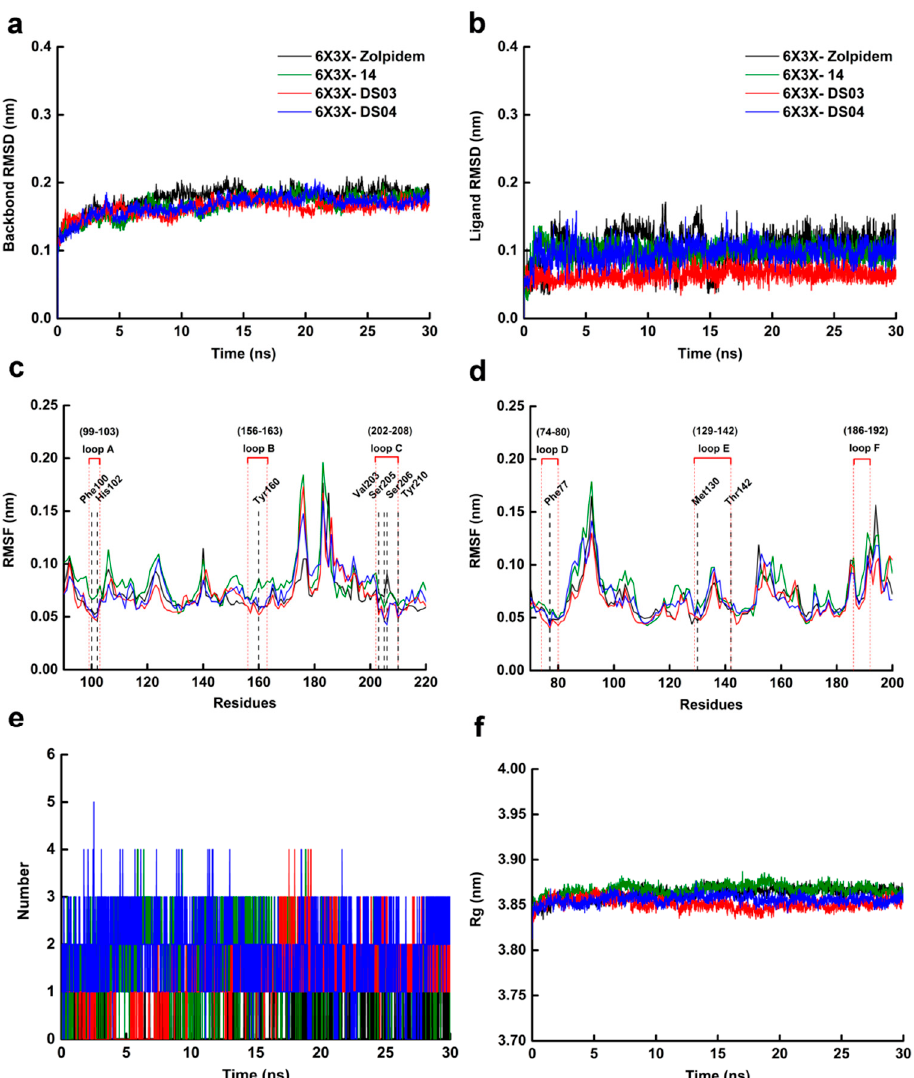
Figure 13. The results of the 30 ns MD simulations of four protein–ligand complexes 6X3X-zolpidem (black), 6X3X- 14 (green), 6X3X- DS03 (red) and 6X3X- DS04 (blue). ( a ) The RMSDs of the 6X3X backbone atoms. ( b ) The RMSDs of compounds (zolpidem, compounds 14, DS03 and DS04 ). ( c ) The residue RMSFs of loop A–loop C in the 6X3X. ( d ) The residue RMSFs of loop D–loop E in the 6X3X. ( e ) The numbers of hydrogen bonds formed between the 6X3X and compounds (zolpidem, compounds 14, DS03 and DS04 ). ( f ) Radius of Rg values of backbone